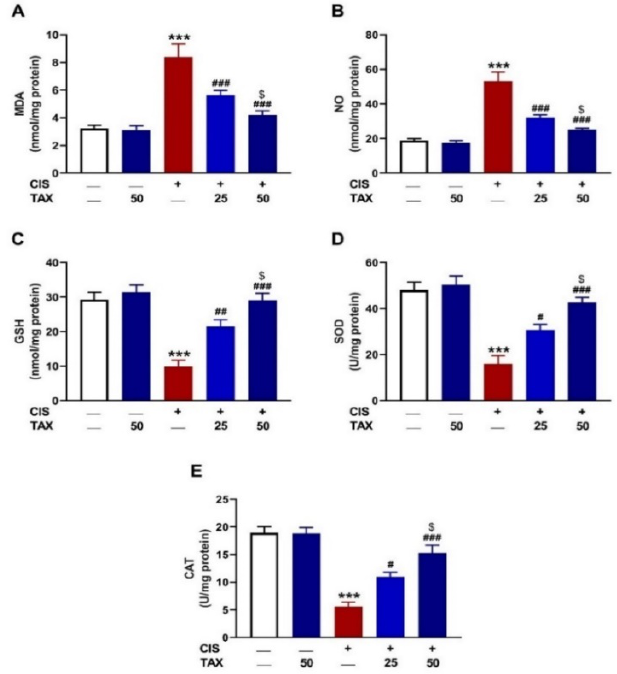
Figure 4. TAX attenuated CIS-induced renal oxidative stress. TAX decreased ( A ) MDA and ( B ) NO, and increased ( C ) GSH, ( D ) SOD, and ( E ) CAT in the kidney of CIS-administered mice. Data are mean ± SEM, ( n = 6). *** p < 0.001 versus Control, # p < 0.05, ## p < 0.01 and ### p < 0.001 versus CIS, and $ p < 0.05 versus TAX (25 mg/kg).